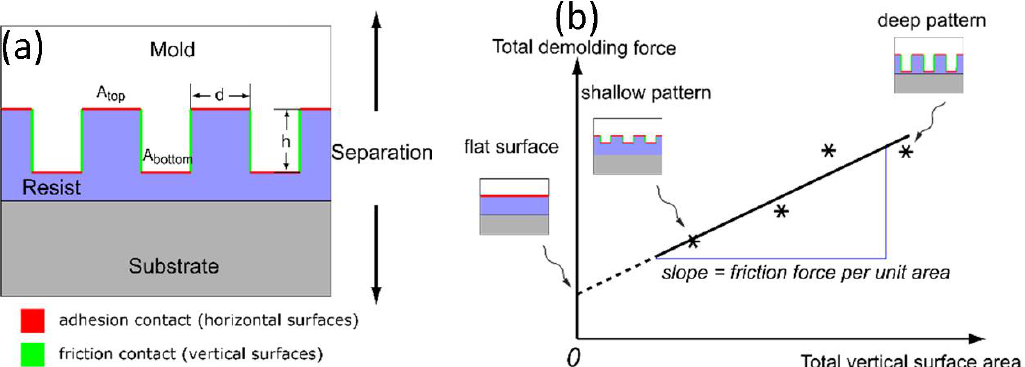
Figure 13. ( a ) A schematic of the adhesion and friction surfaces and pattern geometries; ( b ) a schematic of data acquisition and interpretation to extract adhesion and friction forces in NIL. Reprinted with permission from [133]. Copyright 2021 Elsevier.